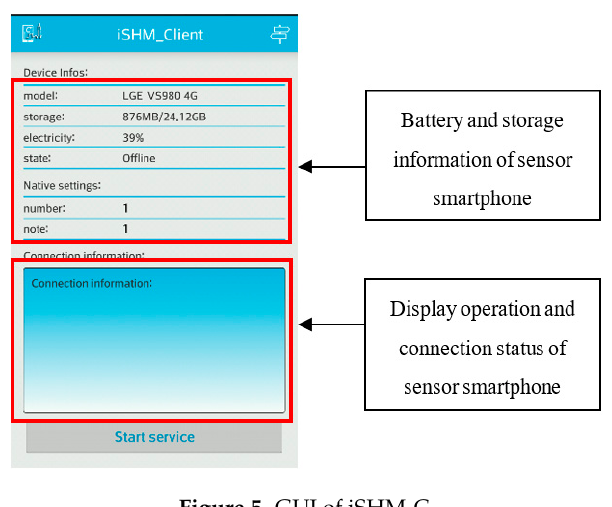
Figure 4. Graphic user interface (GUI) of iSHM-S: ( a ) setting page; ( b ) connect page.